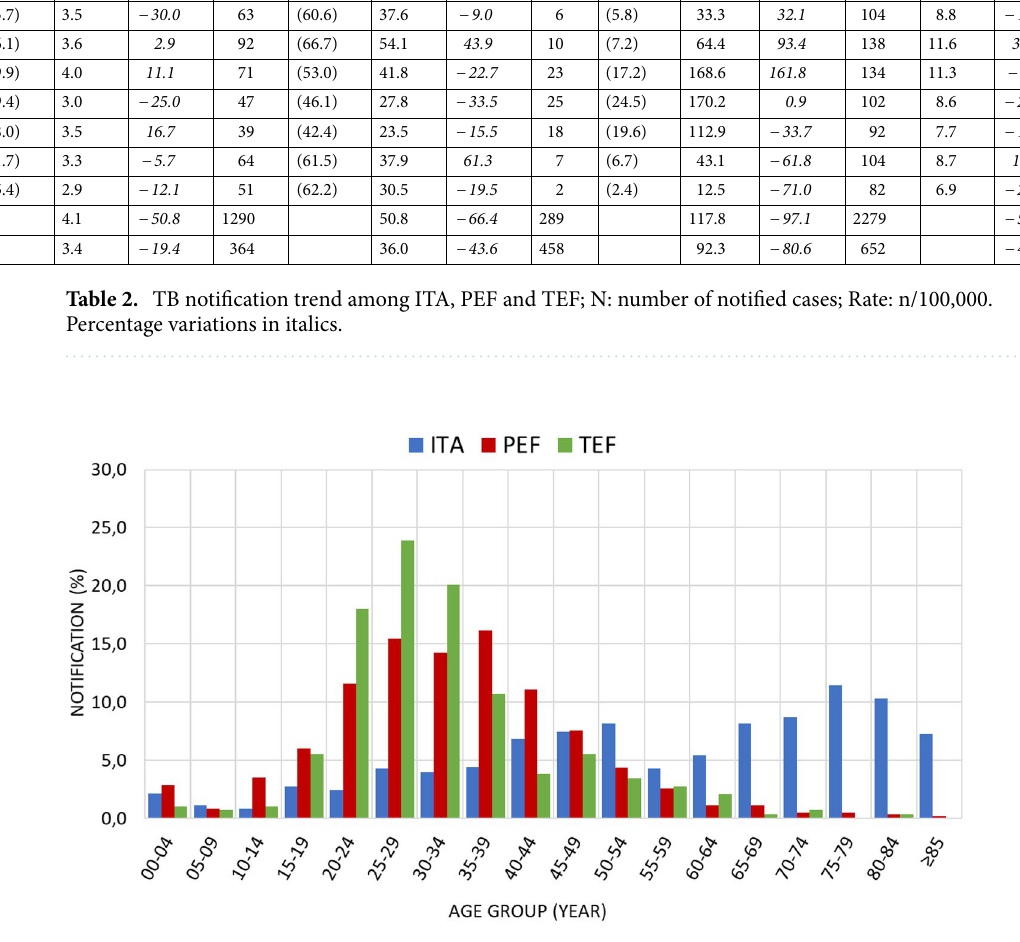
Figure 2. Age distribution of TB cases among ITA, PEF and